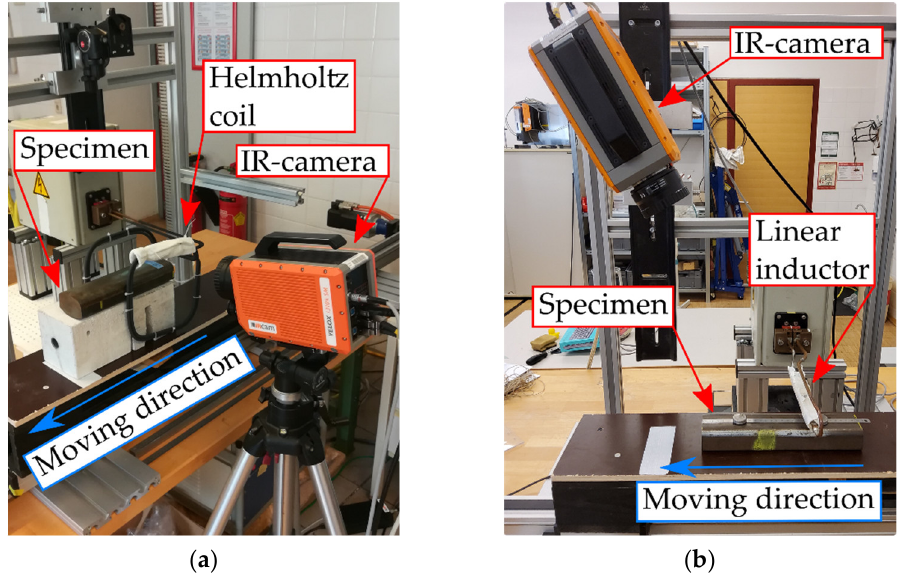
Figure 3. ( a ) Setup for scanning in a stop-and-go technique; ( b ) setup for continuous scanning.